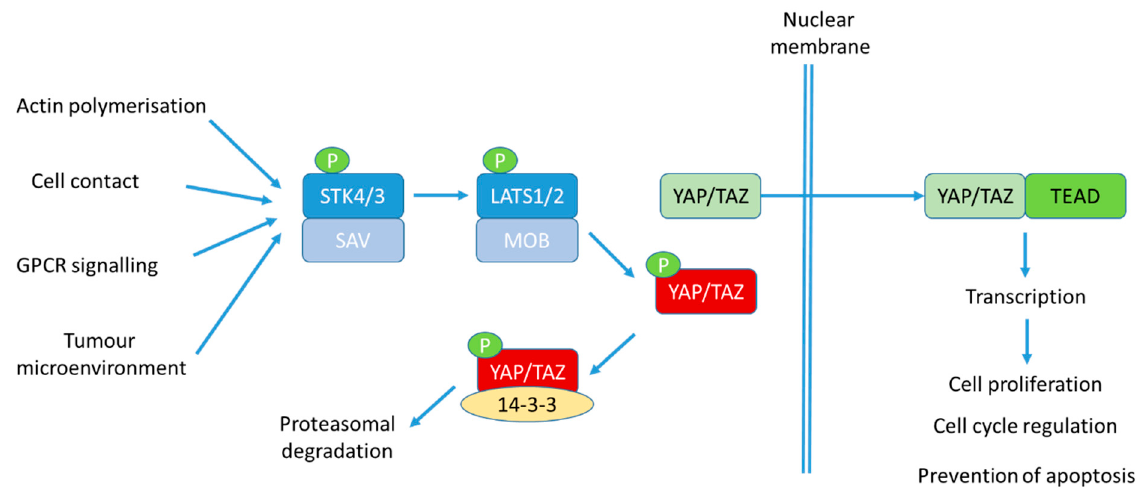
Figure 1. The Hippo pathway. In response to a variety of stimuli, upstream kinases STK4/3 are activated by their interaction with SAV to phosphorylate LATS1/2 and MOB1. LATS kinase activity is activated, resulting in phosphorylation of effector proteins YAP/TAZ. This results in cytoplasmic sequestration and interaction with the chaperone protein, 14-3-3, in the cytoplasm to inhibit its ability to promote transcription. Further phosphorylation of YAP/TAZ then occurs via CK1 to result in β -TrCP-mediated ubiquitination and proteasomal degradation. When YAP/TAZ cannot be phosphorylated, it resides in the nucleus where it can associate with transcription factors, such as Transcriptional Enhanced Associate Domain (TEAD) transcription factors, to stimulate transcription of genes involved in cell proliferation, cell cycle regulation, prevention of apoptosis, migration and invasion.